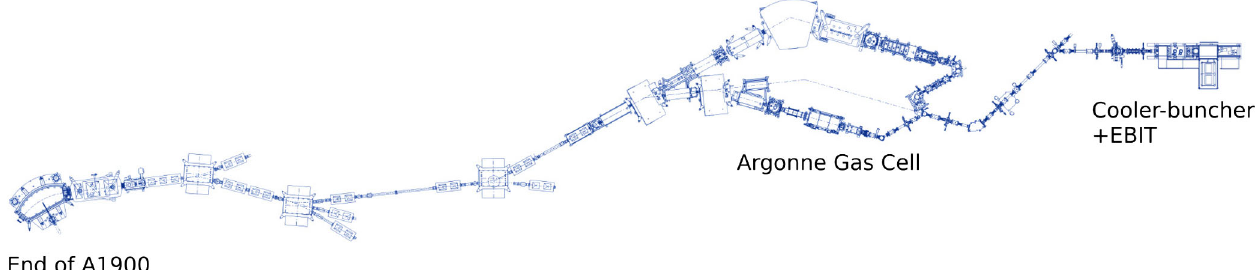
FIG. 1. Schematic layout of the in-flight beam production and beam stopping and charge breeding portions of the National Superconducting Cyclotron Laboratory, from the exit of the A1900 to the exit of the EBIT, with relevant devices labeled. The detectors used in this study were located at these three locations.